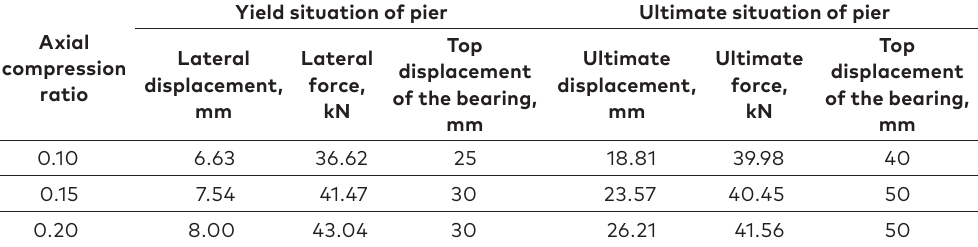
Table 2. Horizontal force of the series system under anchor connection at both ends